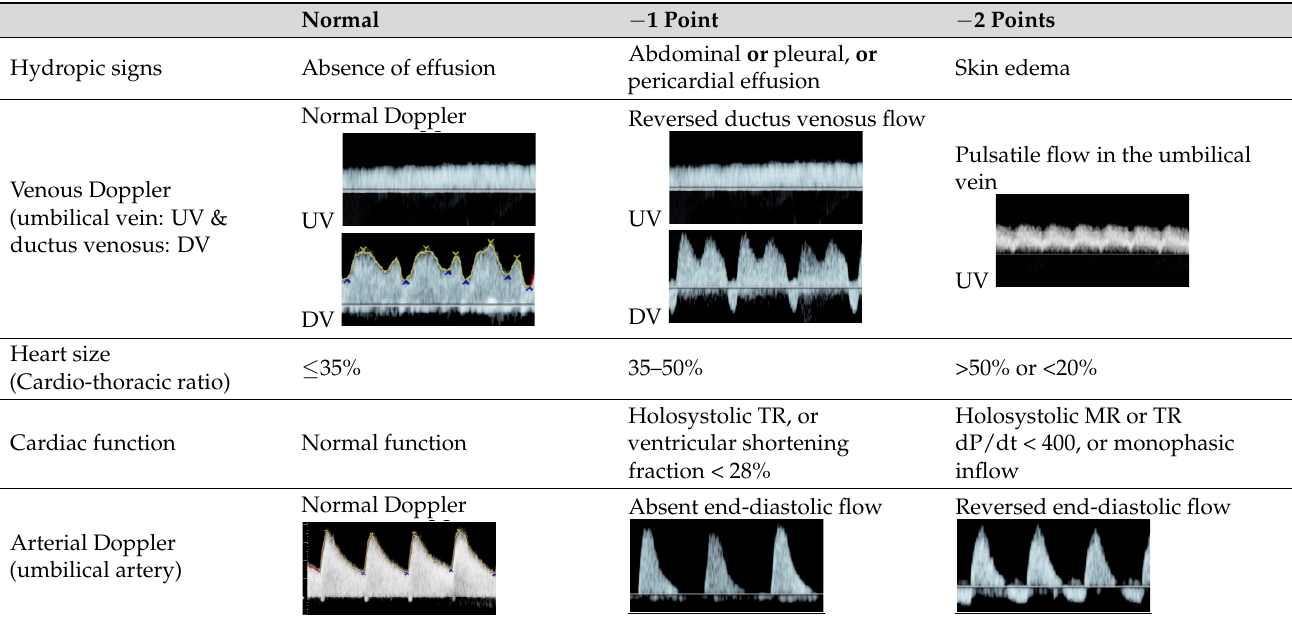
Table 2. Criteria for cardiovascular profile score.